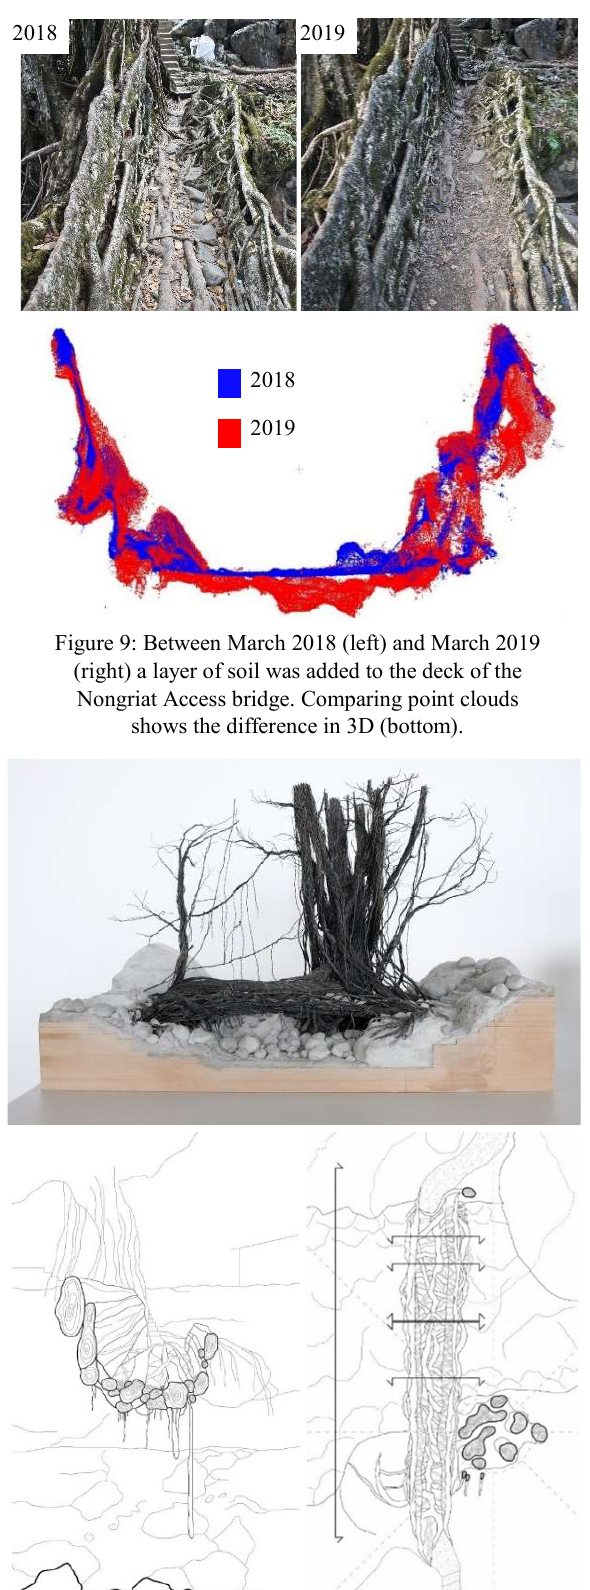
Figure 10: Nongriat Access bridge in modelling concrete and wire (1:25 scale, top), drawn in section diagram (bottom left) and plan (bottom